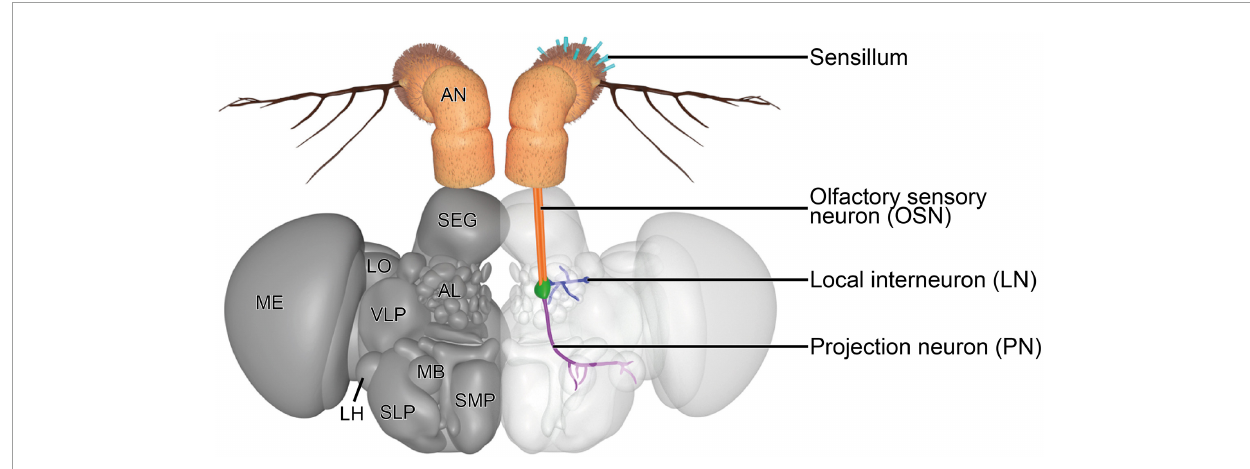
FIGURE3 Three-dimensional render of the brain of D. melanogaster . A representative olfactory circuit is shown. It consists of OSNs (orange) that innervate a specific type of sensilla on the antenna (teal) with their dendrites and a specific glomerulus (green) with their axons. In the glomerulus, OSN axons synapse onto PNs (violet) and LNs (blue). PNs extend their axons to the MB and LH. LNs usually innervate a diverse set of glomeruli to contact OSNs, PNs, and other LNs, mainly to modulate signal transduction. AL, antennal lobe; AN, antenna; LH, lateral horn; LN, local interneuron; LO, lobula; MB, mushroom body; ME, medulla; OSN, olfactory sensory neuron; PN, projection neuron; SEG, subesophageal ganglion; SLP, superior lateral protocerebrum; SMP, superior medial protocerebrum; VLP, ventrolateral protocerebrum. The 3D model is based on published figures (Jenett et al., 2012; Scheffer et al., 2020) and the brain model of NeuroNLP FlyCircuits (Ukani et al.,